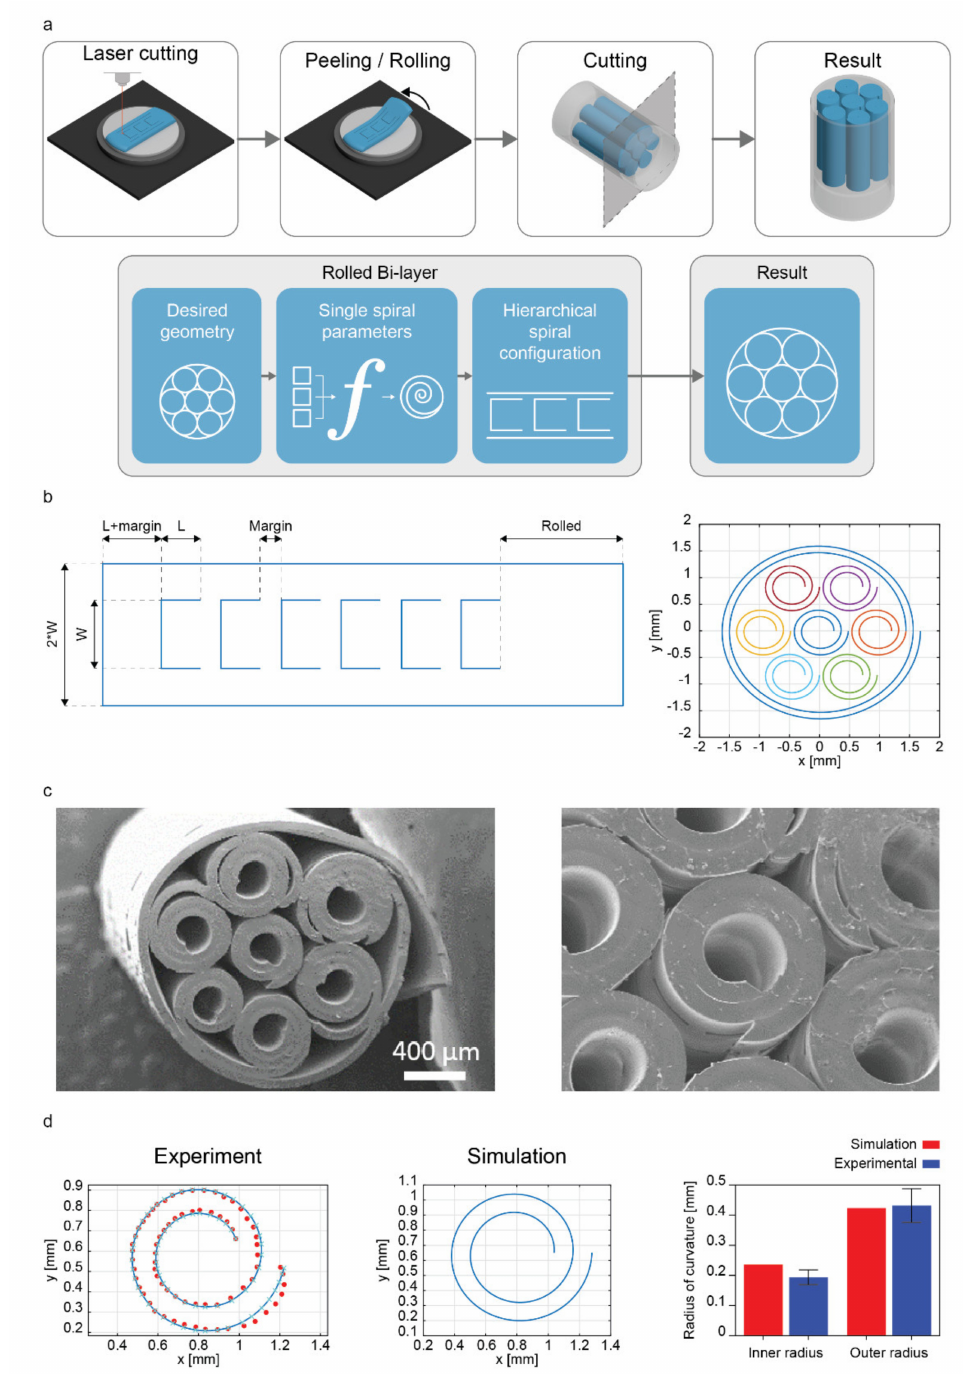
Figure 4. Fabrication and characterization of a bioinspired hierarchical spiral structure. ( a ) Schematic of the fabrication process of the hierarchical rolled structure. ( b ) Representation of the 2D pattern design, used to generate the hierarchical structure. ( c ) SEM images of a hierarchical rolled structure. ( d ) Spiral fitting characterization of the central inner unit of the hierarchical spiral and comparison between model (simulation) outcomes and experimental